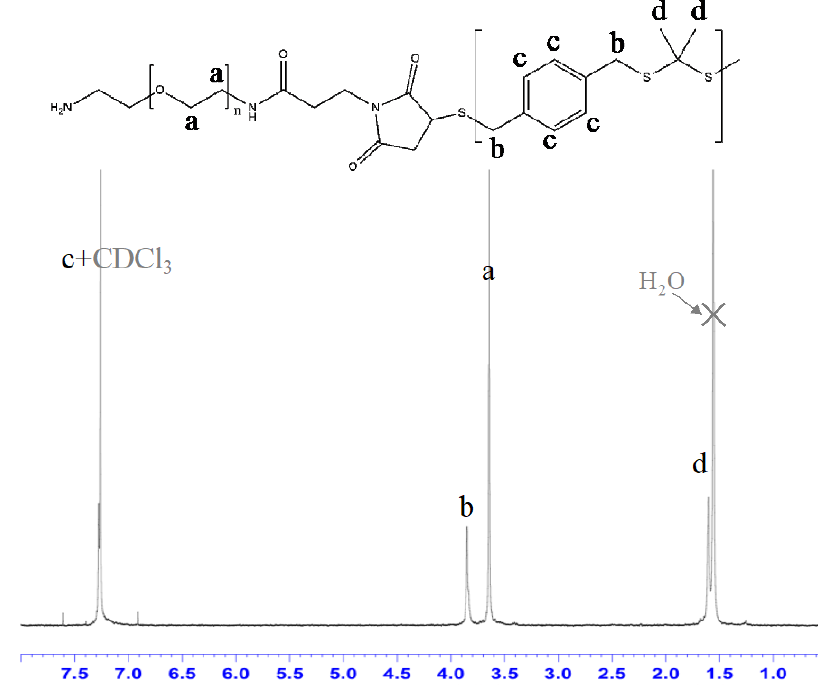
Figure 2. Characterizations of block copolymers, and 1 H NMR of NH 2 -PEG-PPADT. The MMAF-loaded BBN-PEG-PPADT nanoparticles (MMAF@BBN-PEG-PPADT) were prepared by hydrophobic interactions between benzene groups in PPADT and MMAF. The amounts of MMAF in the MMAF@BBN-PEG-PPADT were determined by reverse-phase HPLC (RP-HPLC) (Figure 3). The loading contents were 12.16 ± 0.64 wt %, and the loading efficiency was 91.29 ± 0.01%.